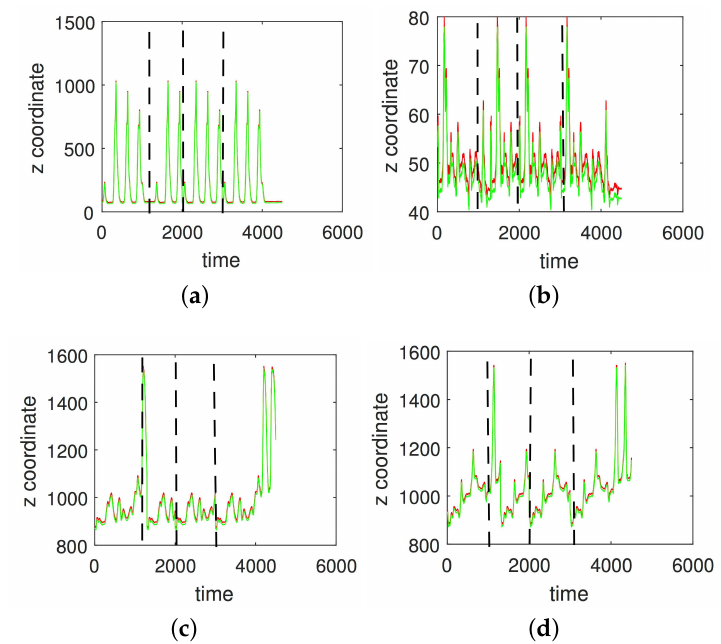
Figure 6. An approximation of z -coordinates by 100 satellites and two centers of motion (CMU 86 Trial 1; sampled at 120Hz). ( a ) Right heel; ( b ) The left heel; ( c ) Right wrist, distal; ( d ) The left wrist, distal. The red curve shows the experimentally observed coordinates and the green curve gives their neural